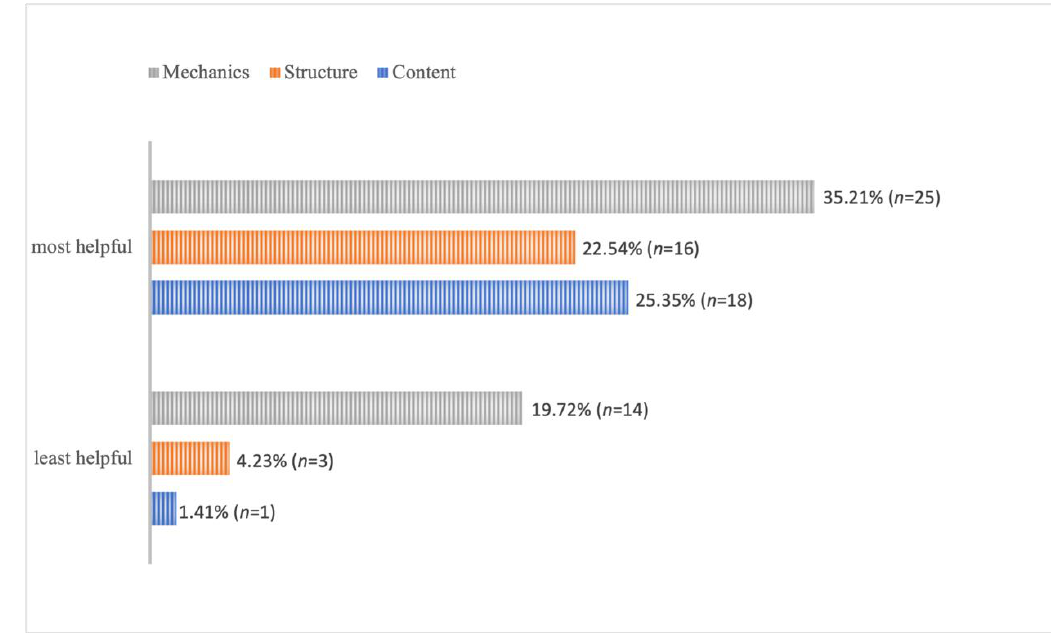
Figure 3. Students’ Perceptions of th e Most and Least Helpful Feedback. Table 2. Students’ Perceptions of Writing Mechanics